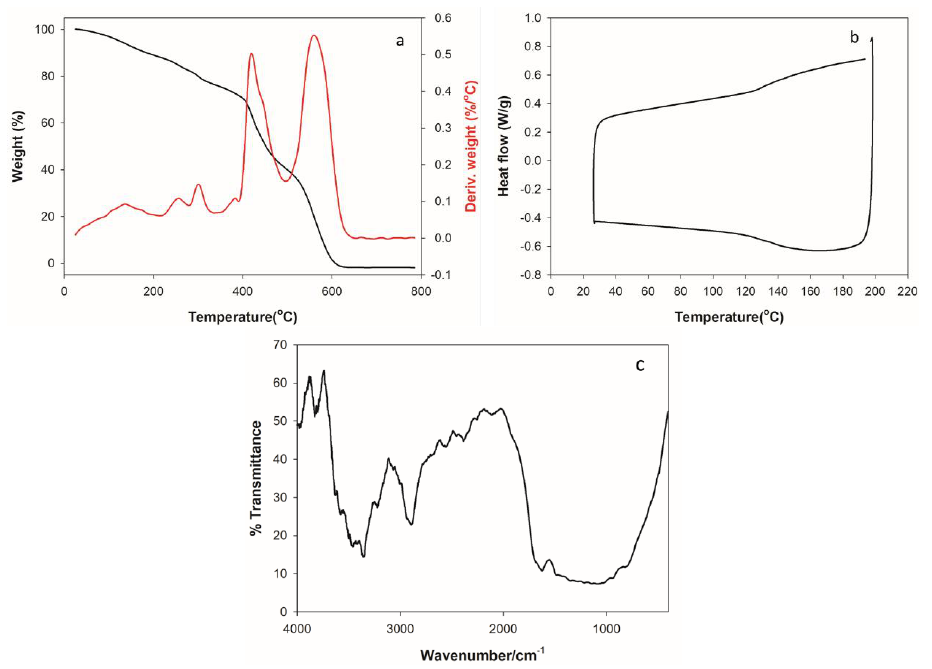
Figure 1. Thermogravimetric analysis (TGA) thermogram ( a ) and Differential Scanning Calorimeter (DSC) thermogram ( b ) and fourier transform infrared spectroscopy (FT-IR) spectrum ( c ) of polymer 9 .